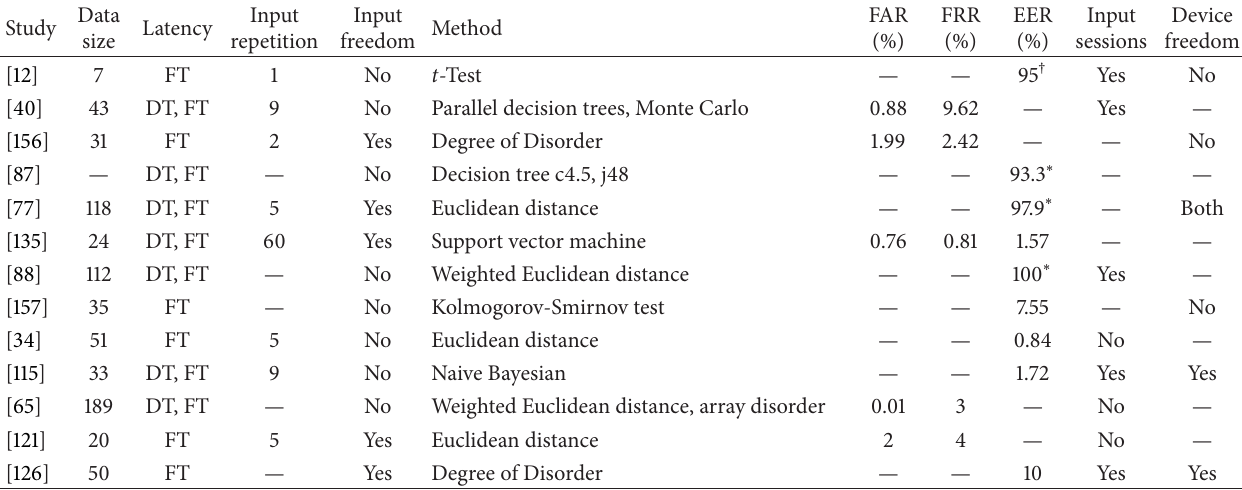
Table 5: Comparison between research works with static authentication mode (long inputs). Data Study